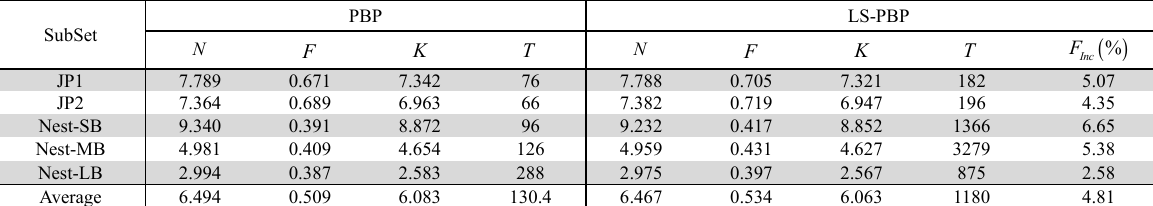
Comparison between PBP and